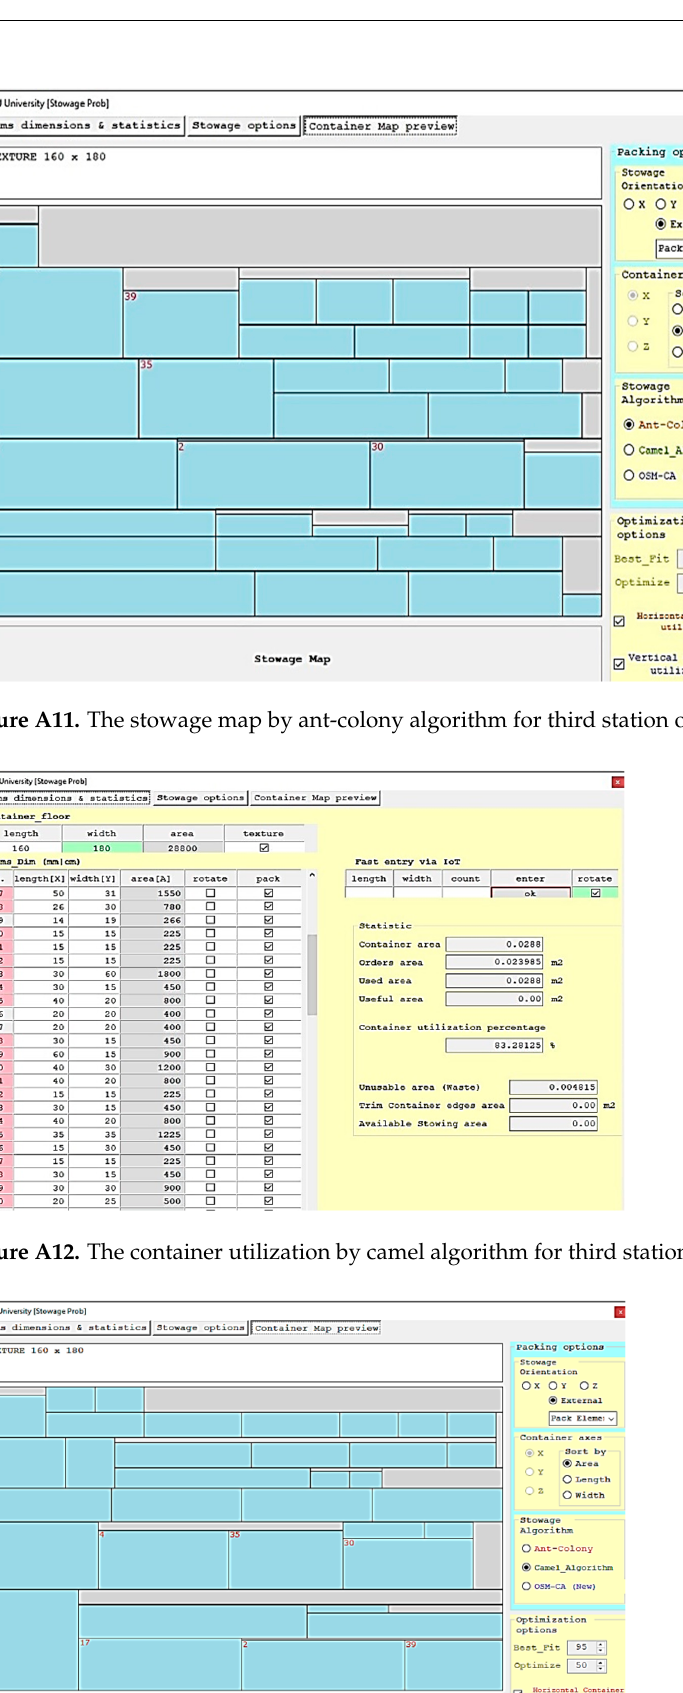
Figure A10. The container utilization by ant-colony algorithm for third station on the distribution path.